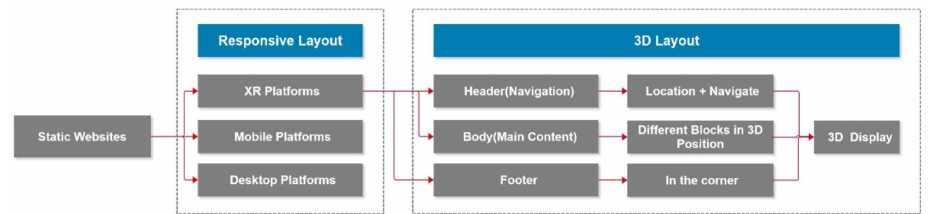
Figure 5. A 3D layout concept for static websites.